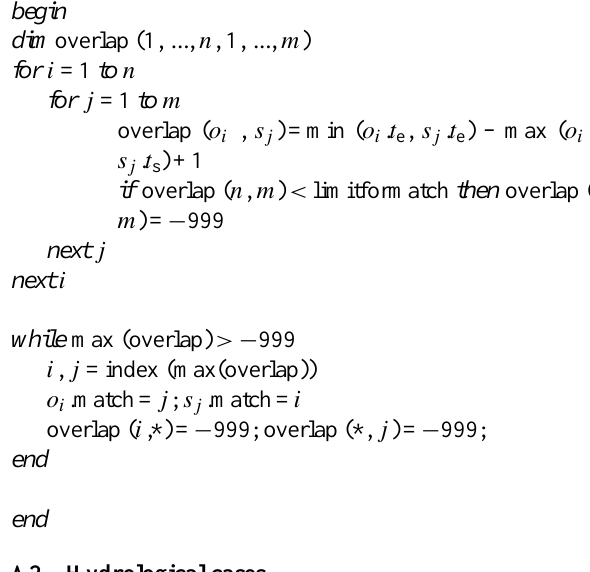
Algorithm to find the hydrological case for each time step